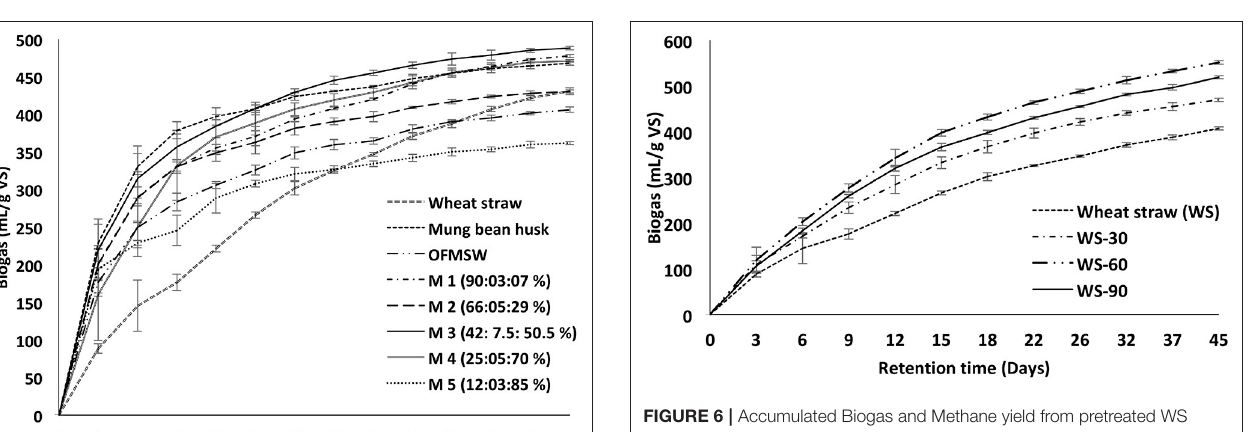
FIGURE 6 | Accumulated Biogas and Methane yield from pretreated WS